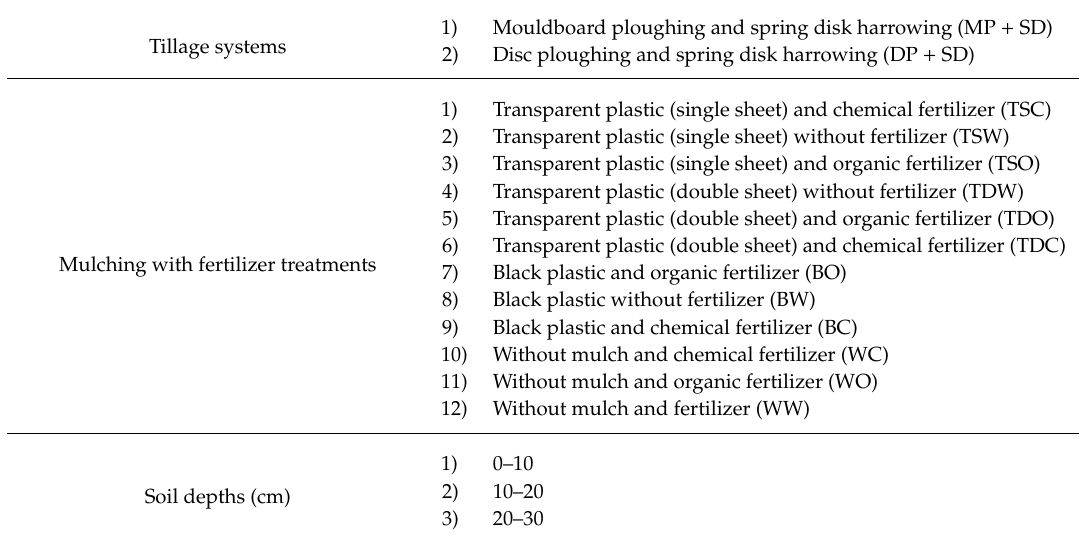
Table 2. Interactions between experimental factors testing the digital electromechanical system (DES) performance, tillage systems, mulching treatments, and soil